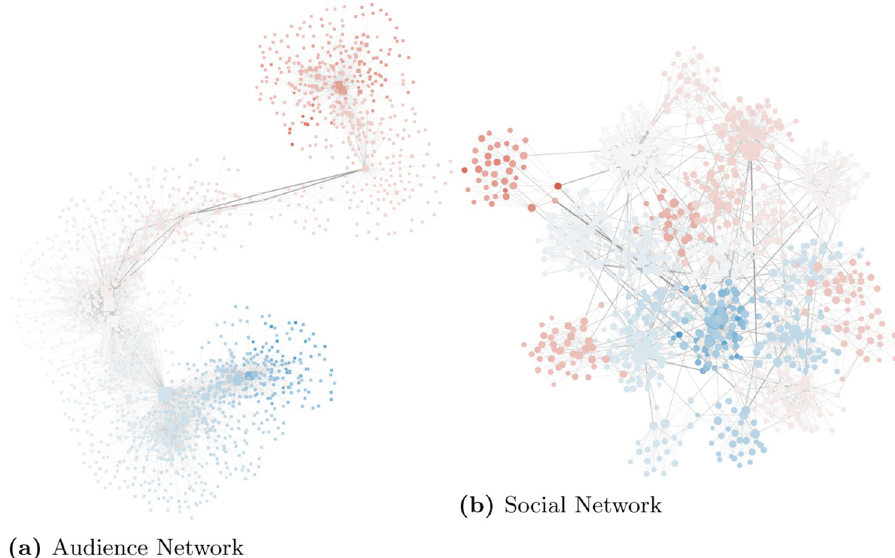
Fig 2. The audience and social network. Each circle is a user and each square is a news source. The colors of circles and squares represent their polarity from − 1 (blue) to +1 (red). Each user is connected to the news sources they follow in the audience network and to their friends in the social network. The size of the node is proportional to their degree. Edge thickness and opacity proportional to the edge betweenness. (a) Audience Network. (b) Social